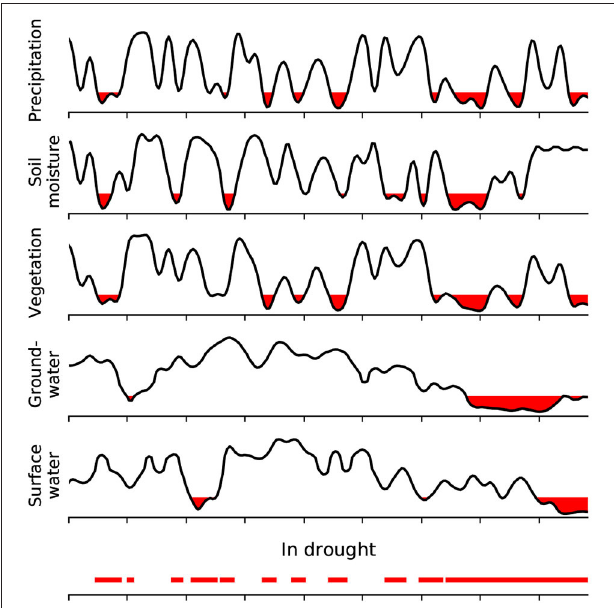
FIGURE 1 | Conceptual illustration of drought propagation. Time series can be interpreted as percentile values for each particular month. Red areas indicate periods below the drought threshold (here 20% reflecting mild drought and worse). Note that propagation increases the fraction of time that any of the variables is in drought to more than 20% (lower